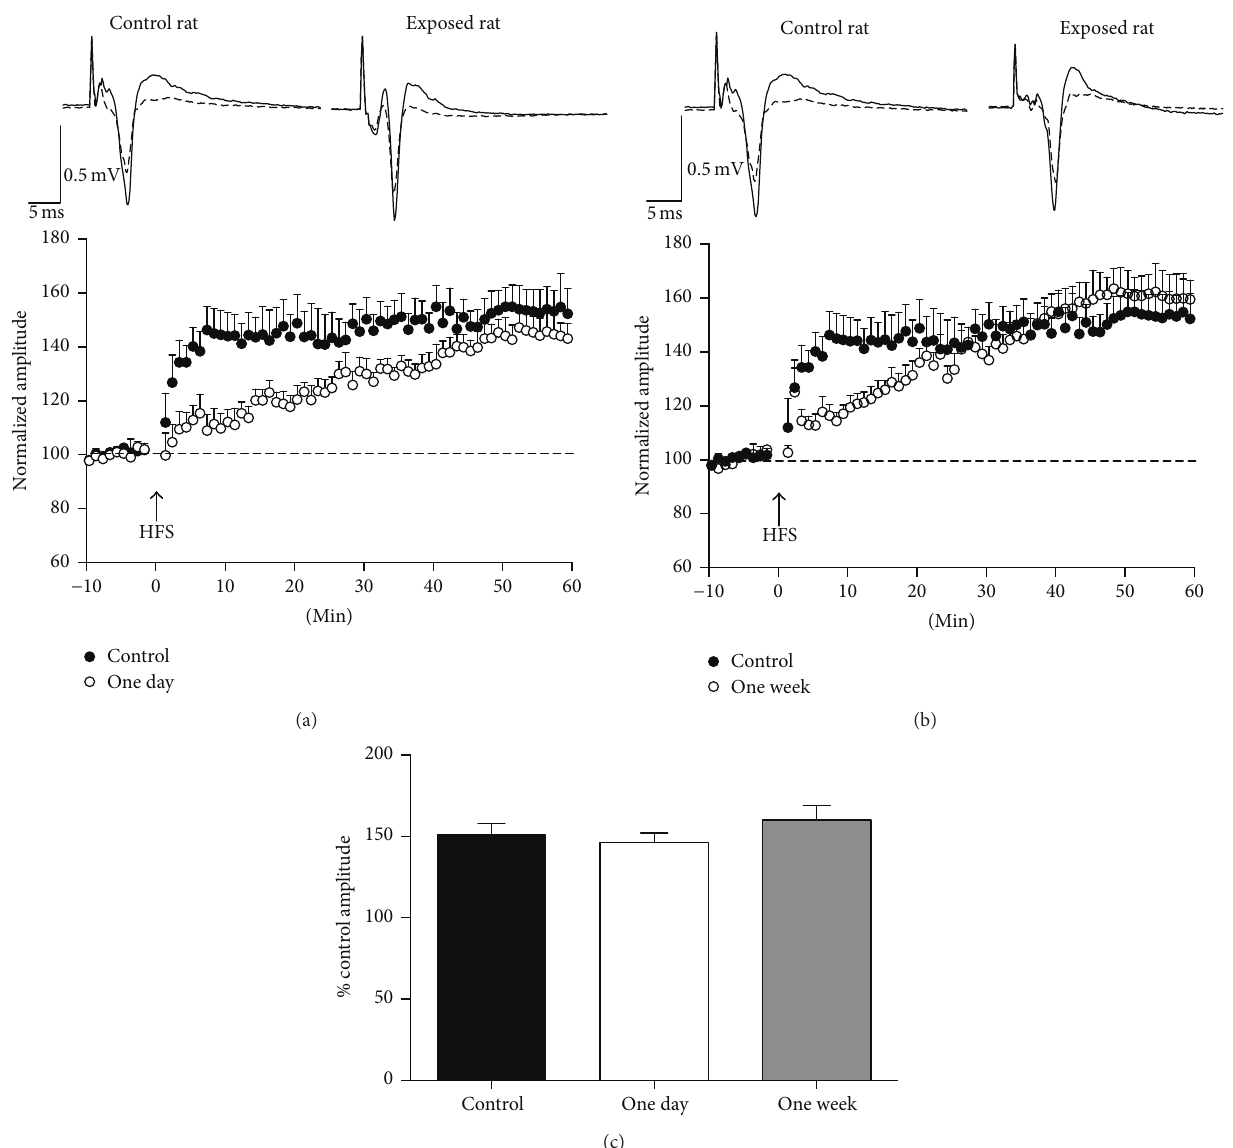
Figure 1: Single isoflurane exposure for 1 h had no significant effect on the magnitude of LTP in the BLA. Field potentials were evoked in the BLA by stimulation of the external capsule. (a) and (b) show the time course of the changes in the amplitude of the responses after high- frequency stimulation (HFS), in control rats (black circles) and rats exposed to a single, 1h long isoflurane anesthesia (open circles), 1 day (a), and 1 week (b) after the exposure. The amplitudes of three responses recorded in each min (stimulation at 0.05 Hz) were averaged, and each data point on the plot is the mean and standard error of these averages, from 9 to 11 slices. Traces over the plots are examples from a control rat and from isoflurane-exposed rats; the superimposed field potentials are a baseline response and a response at 50 to 60 min after HFS (each trace is the average of 10 to 20 sweeps). (c) Group data of the mean amplitudes during the 50 to 60min time window after HFS, expressed as % of the control (baseline) amplitude. Sample sizes, 𝑛 = 10 for the control group, 𝑛 = 9 for the 1-day group, and 𝑛 = 11 for the 1-week